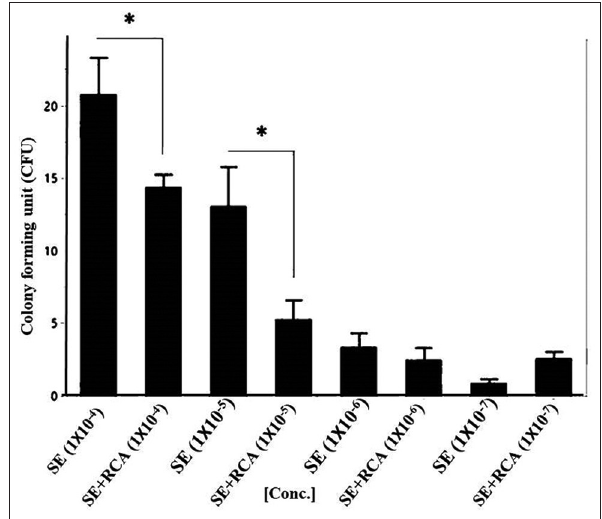
Figure-2: Salmonella Typhimurium (ST) on Luria-Bertani agar. ST isolate was 10-fold serially diluted and mixed with a constant concentration of anti- Salmonella DNA aptamers in the form of rolling circle amplification. The colony-forming unit was calculated and blotted with a concentration of the rolling circle amplification (RCA) products. The RCA products showed a significant ability to reduce the growth of the bacteria (p<0.01) except in 1×10 –6 where the reduction was not significant.